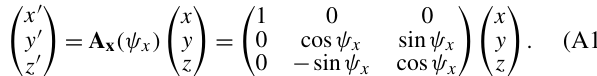
Figure A1. Schematic diagram of Coordinates rotation.